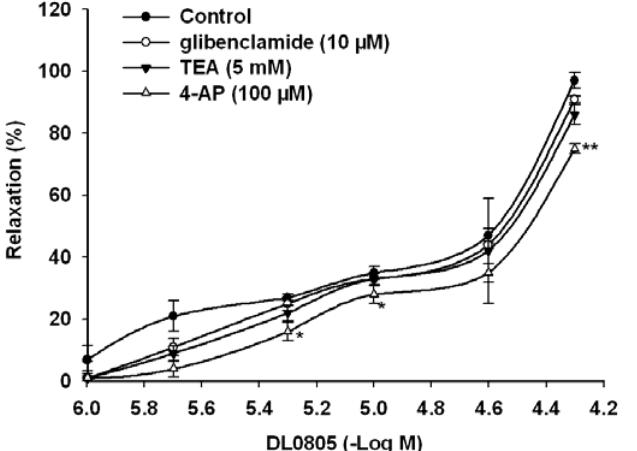
Figure 3. Effects of pre-incubation of glibenclamide (10 μ M), TEA (5 mM) and 4-AP (100 μ M) on DL0805 induced relaxation in thoracic aorta rings precontracted by NE (1 μ M). Results are presented as means ± S.E.M., n = 6, * P < 0.05, ** P < 0.01 compared with control.